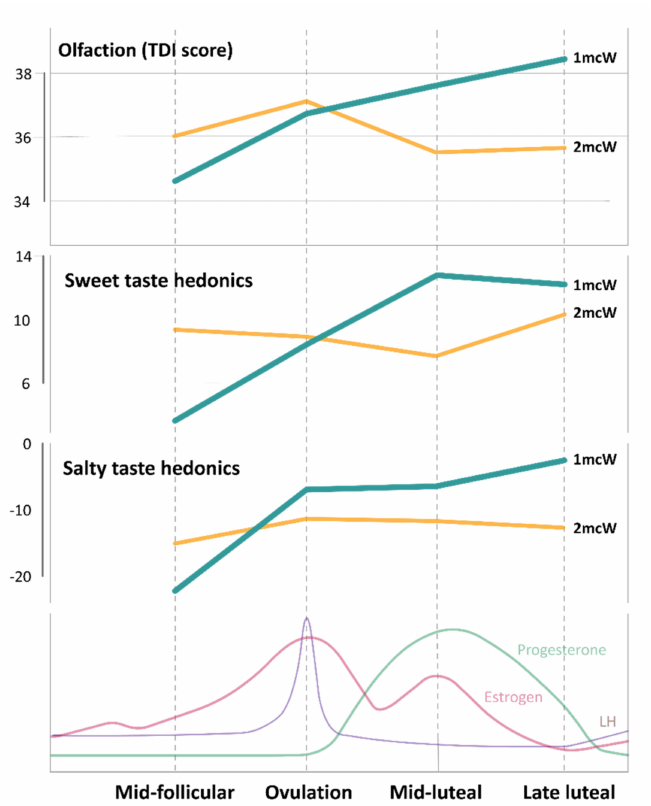
Figure 2. TDI score, sweet taste hedonics, and salty taste hedonics across four phases of the menstrual cycle in two main study groups (1mcW - women measured across consecutive phases of one complete menstrual cycle; 2mcW - women measured across phases of two different, consecutive menstrual cycles; all values are presented as means, while error bars are not shown to improve figure